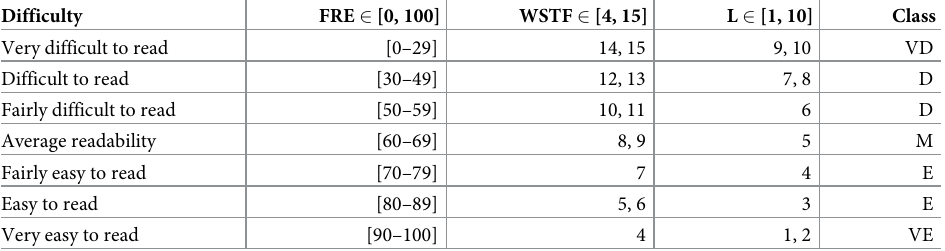
web sites (44.07%, 1322/3000), a score between > 4 and < 9 corresponds to a level suitable for persons with medical knowledge or a strong medical background. The web sites of the ccTLD “.at” scored the lowest vocabulary measure with L = 5.796 (SD = 2.543), followed by L = 5.885 (SD = 2.499) for web sites under the ccTLD “.ch”. Web sites under the ccTLD “.de” scored the highest vocabulary measure with L = 6.340 (SD = 2.572). The distribution of the classification results over all web sites is depicted in Fig 6. Table 4. Mapping readability and vocabulary scales to corresponding classes as follows: VE very easy; E easy; M moderate; D difficult; VD very difficult according to Wiesner et al. [25]. Difficulty Difficult to